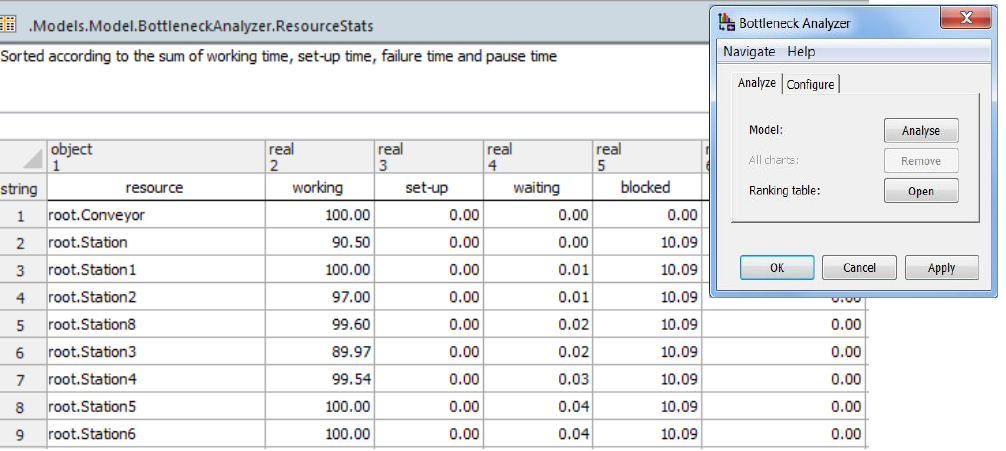
Figure 9. Statistics concerning the work of machines in the production process after optimization.